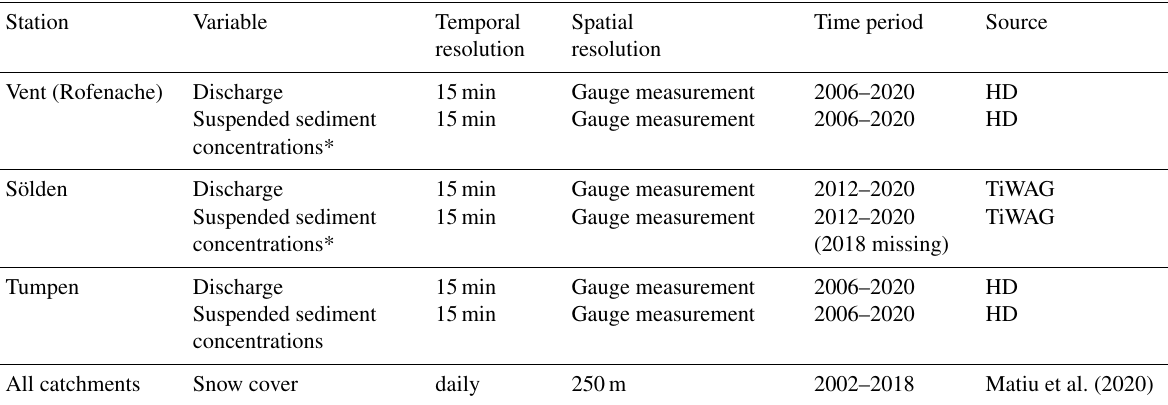
Table 2. Characteristics and sources of investigated data (HD: Hydrographic Service of Tyrol, Austria; TiWAG: Tiroler Wasserkraft AG/hy- dropower company of Tyrol). * Turbidity measurements in Vent and Sölden are interrupted during the winter months to prevent damage to the equipment by